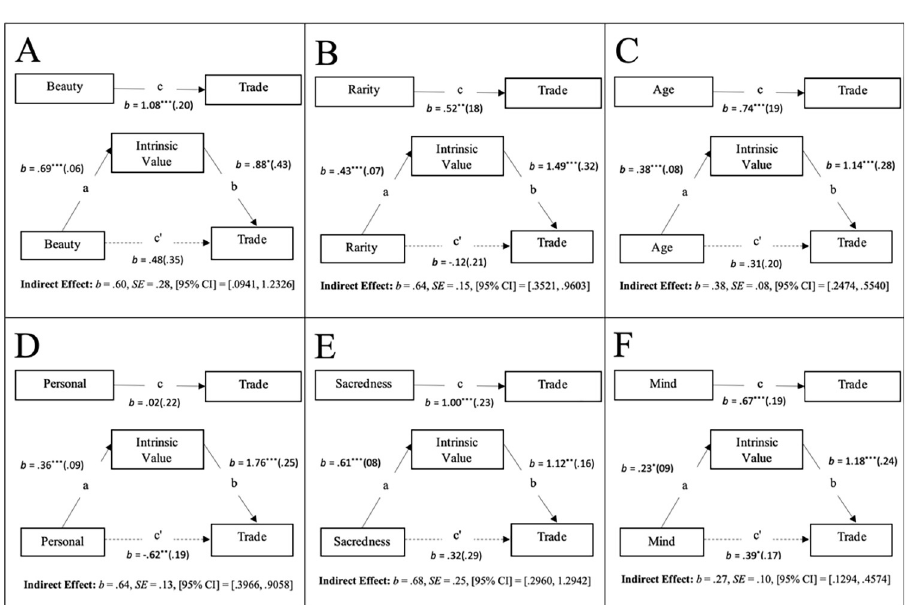
Fig 3. Mediation models for value tradeoffs Study 4. Notes: Unstandardized Coefficients and Standard Errors (in Study 4) for effects of Beauty (Panel A), Rarity (Panel B), Age (Panel C), Personal (Panel D), Sacredness (Panel E) and Mind Possession (Panel F), on “How much money it would take for them to destroy each entity ... ”, via the Mediator of Intrinsic Value. In each panel, the top model represents the total effect, and the bottom model represents the direct/ indirect